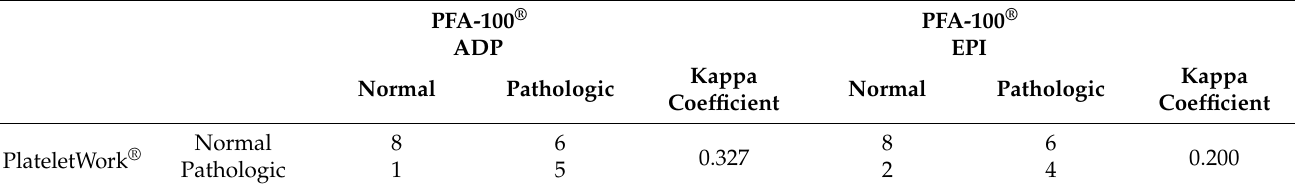
Table 2. Concordance between PlateletWork ® (Helena Laboratories, Beaumont, TX, USA) and PFA-100 ® (Siemens Canada, Mississauga, ON, Canada) considering the first blood